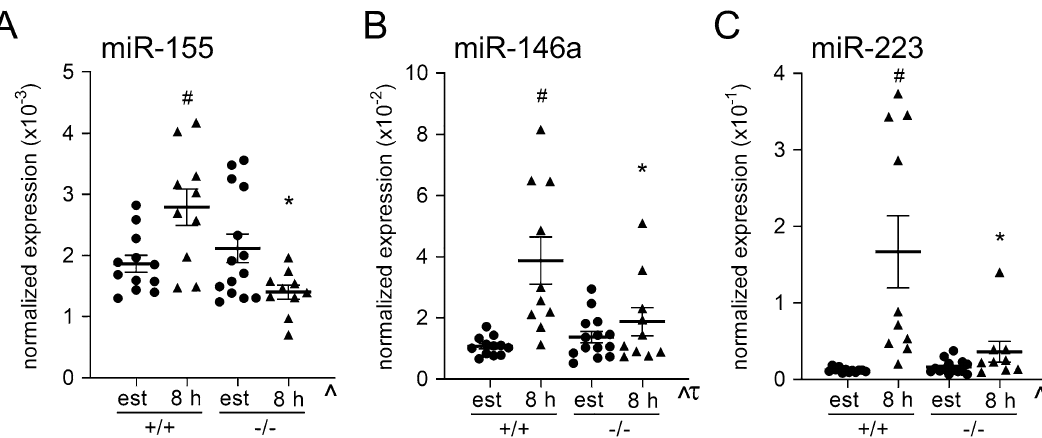
Figure 3. Effect of maternal TLR4 deficiency on mating-induced expression of immune-regulatory miRNAs in the uterine endometrium. miRNA recovered from endometrial tissue of Tlr4 + / + (+/+) and Tlr4 −/− (−/−) mice at estrus, or at 8 h after mating with B6 males, was analyzed by Taqman assays to quantify microRNA expression. miRNA expression was normalized to U6snRNA using the delta C(t) method. ( A ) miR-146a, ( B ) miR-155, and ( C ) miR-223. Symbols depict individual mice (n = 10–14/group) and data are shown as mean ± SEM. Effects of mating and genotype were assessed by one-way ANOVA with post-hoc Sidak’s multiple comparison test (* p < 0.05 versus same time point in Tlr4 +/+ females, # p < 0.05 versus estrous control within genotype). The overall effect of genotype and mating was assessed by two-way ANOVA (τ p < 0.05 difference attributable to mating; ^ p < 0.05 difference attributable to an increase in Tlr4 −/− mice. TLR4 deficiency did not impact the amount of FOXP3 expression in total Treg, tTreg, or pTreg cells after mating, as assessed by FOXP3 MFI (Supplemental Fig. S3). To assess whether TLR4 deficiency impacted Treg cell phenotype in the peri-implantation phase, the sup- pressive marker CTLA4 33 and the marker of proliferation Ki67 were analyzed in dLN Treg, NRP1 + tTreg and NRP1 − pTreg populations. Compared to estrous mice, mating induced a 5.1-fold increase in the absolute number of Treg cells expressing both CTLA4 and Ki67 ( p < 0.003) (Fig. 5A) in Tlr4 + / + mice, a subset we showed previously to be selectively increased after mating 6,12 . No increase was seen in response to mating in Tlr4 −/− mice, where CTLA4 + Ki67 + Treg cells were 63% fewer than in mated Tlr4 + / + mice ( p < 0.030) (Fig. 5A). A similar pattern was seen in both the NRP1 + tTreg (Fig. 5B) and NRP1 − pTreg (Fig. 5C) subpopulations. Elevated expression of Ki67 was most notable, such that in Tlr4 + / + mice, mating induced a 1.6-fold increase in the proportion of proliferating Treg cells positive for Ki67 ( p = 0.044) (Fig. 5D), evident in both the NRP1 + tTreg (Fig. 5E) and NRP1 − pTreg (Fig. 5F) cells. In contrast, Tlr4 −/− mice did not exhibit any change in Ki67 in total Treg cells (Fig. 5D), NRP1 + tTreg cells (Fig. 5E), or NRP1 − pTreg cells (Fig. 5F) after mating. The proportion of total Treg (Fig. 5G), NRP1 + tTreg (Fig. 5H), and NRP1 − pTreg (Fig. 5I) expressing CTLA4 was not changed after mating and not impacted by TLR4 deficiency. tSNE analysis was utilized to gain insight on whether TLR4 deficiency differentially impacted Treg cell generation in the dLN after mating. Flow cytometry data on dLN CD4 + T cells from mated Tlr4 − / − and Tlr4 +/+ mice stained for CD4, FOXP3, CD25, NRP1, CTLA4, and Ki67 were concatenated and transformed into two- dimensional projections using the tSNE algorithm. Inspection of density and contour plots revealed 5 distinct clusters, amongst which subpopulations of FOXP3 + CD4 + T cells with the characteristics of tTreg and pTreg cells could be located (Fig. 6A,B). There was no difference in the relative proportions of different FOXP3 + or FOXP3 − clusters attributable to TLR4 deficiency (Fig. 6C,D). This confirms there was no substantial differential impact of TLR4 deficiency within the Treg cell compartment, and that fewer Treg cells after mating in Tlr4 − / − mice reflects an impaired response in the whole CD4 + T cell population.